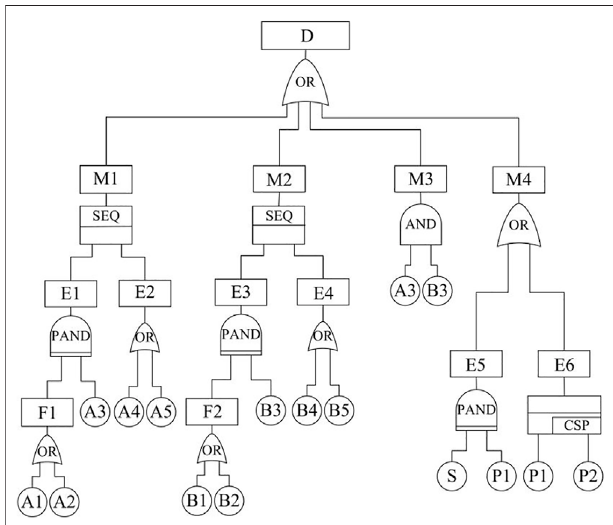
FIGURE 3 | DFT for the